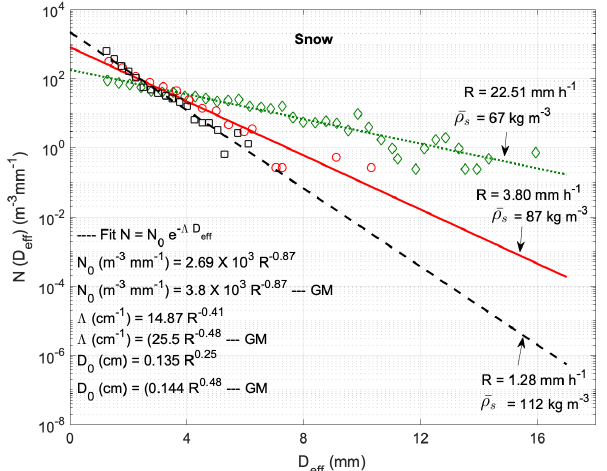
Figure 15. Size distributions of snow particles for different SWE rates ( ˙ SWE). Approximately 2000 snowflakes were considered in each case with bin sizes of 0.2mm. The mean snow density is taken by averaging over ≈ 2000 snowflakes. Distribution of snowflakes (points) on a plot of log number vs. effective circular diameter ( D eff ), fitted using N(D eff ) = N 0 e − (cid:51)D eff (lines). R is the SWE rate of snowfall ( ˙ SWE), and D 0 is the median of D eff . Fitted results are compared with Gunn and Marshall (1958), abbreviated as